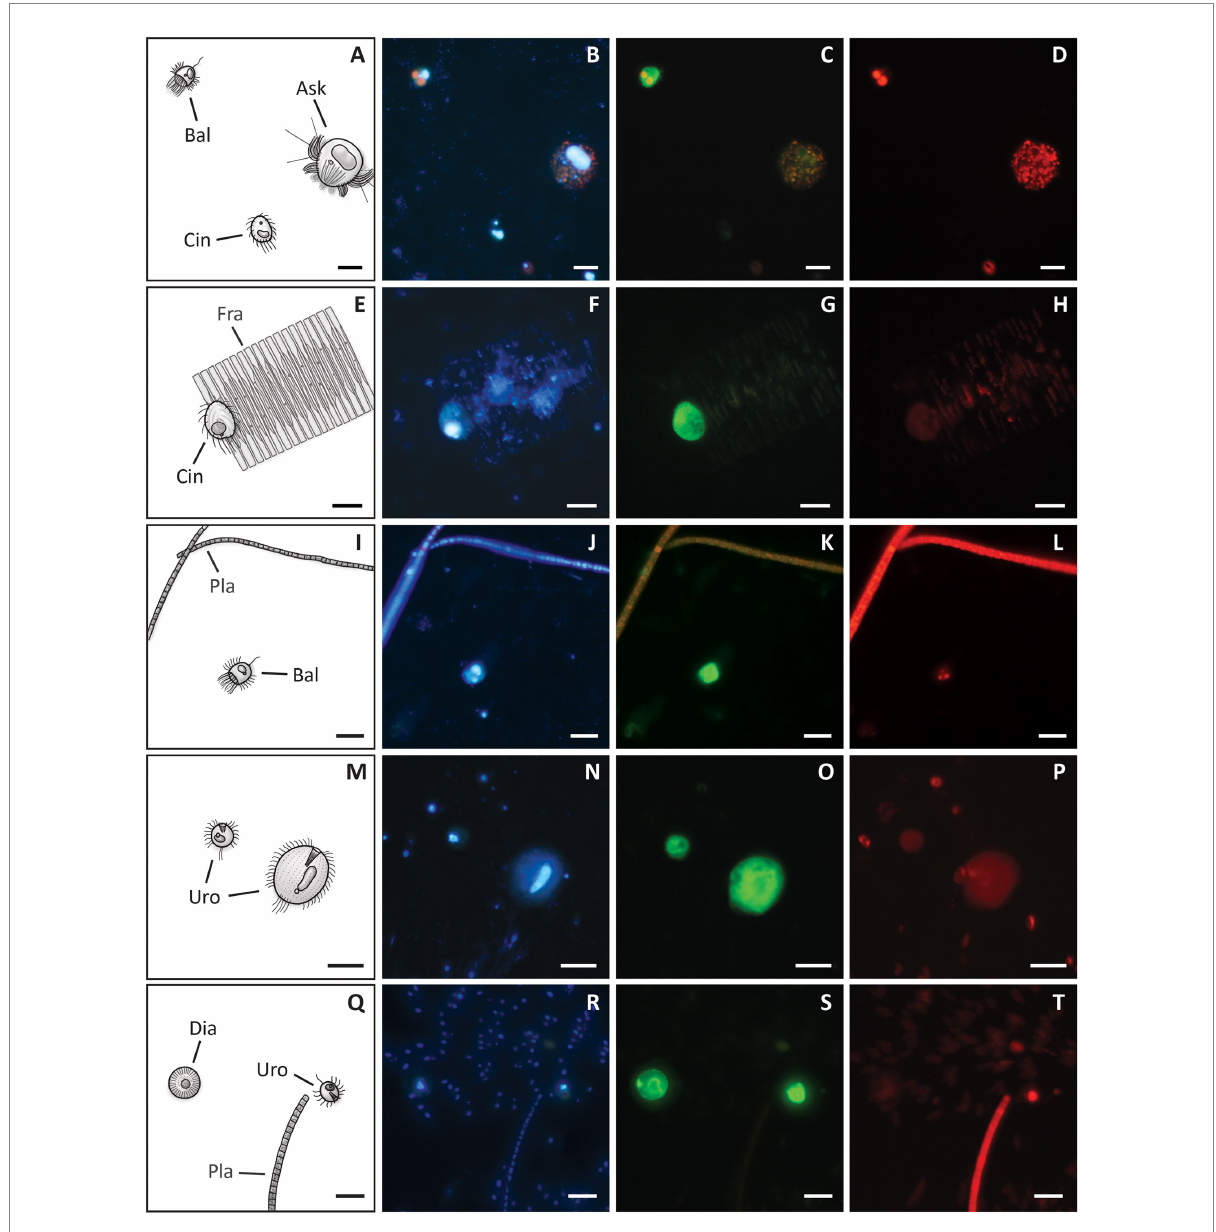
FIGURE 6 Drawings (first column) and associated photographs of CARD-FISH of the mock assemblage and water samples from Lake Zurich. Photographs in each row show the same area on the filter and were taken using different optical filters visualizing DAPI-staining of nuclei (second column), hybridized cells (third column) and chlorophyll a autofluorescence (fourth column). CARD-FISH was performed with the mock assemblage and B. planctonicum -probe Bal-651 (A–D) , the mock assemblage mixed with lake water and C. margaritaceum -probe Cin-1237 (E–H) , lake water and B. planctonicum -probe Bal-651 (I–L) , and lake water with the Urotricha genus-specific probe Uro-all-651 (M–T) . Note ingested algae within A . cf. volvox (D) , B. planctonicum (D, L) and Urotricha spp. (P, T) , and the false positive signal of centric diatoms (S) . The drawings present some organisms found on the CARD-FISH preparations: (Ask) A . cf. volvox , (Bal) B. planctonicum , (Cin) C. margaritaceum , (Dia) centric diatom, (Frag) Fragilaria sp., (Pla) Planktothrix rubescens , (Uro) Urotricha sp. Scale bars = 20 μ